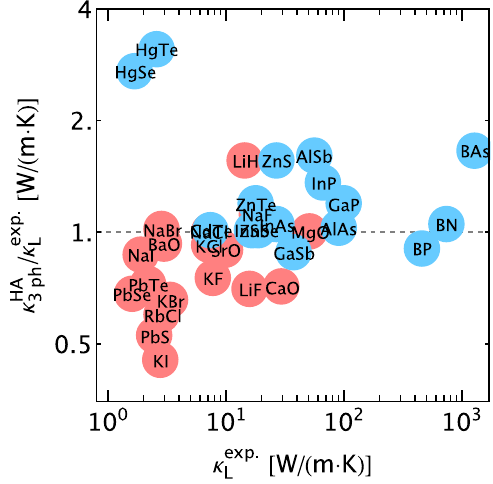
FIG. 1. Comparison of theoretically calculated ( κ HA 3 ) and ph experimentally measured ( κ exp ) lattice thermal conductivities in L selected binary rocksalts (red disks) and zinc blendes (blue disks) at 300 K. The theoretical values are calculated at the level of HA þ 3 ph, namely, phonon dispersion from the HA and phonon scattering rates from 3ph scattering processes. The ratio of κ HA κ exp is calculated by dividing the theoretical value by the 3 ph = L higher end of the experimental values, both listed in Table